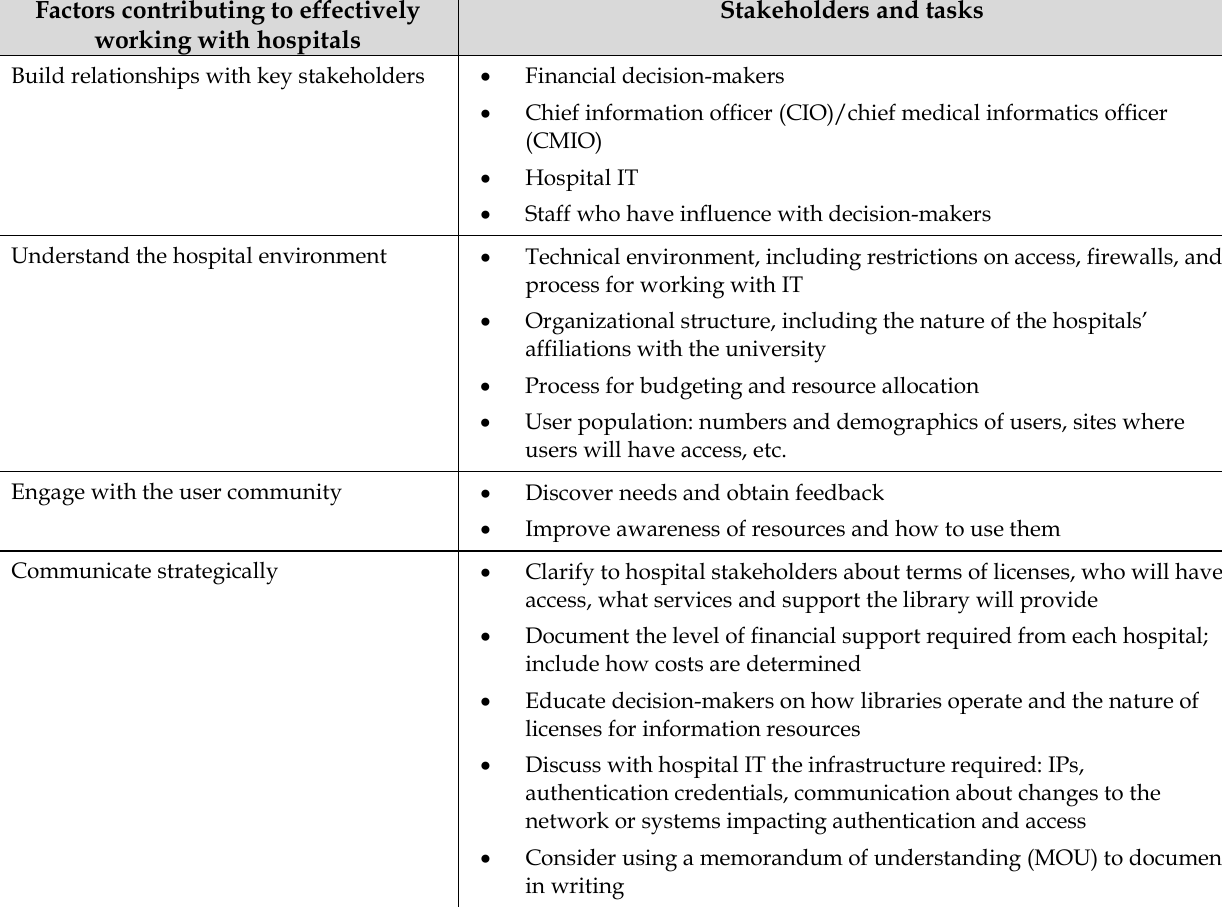
Table 4 Themes related to libraries’ practices enabling effective collaboration with affiliated hospitals Factors contributing to